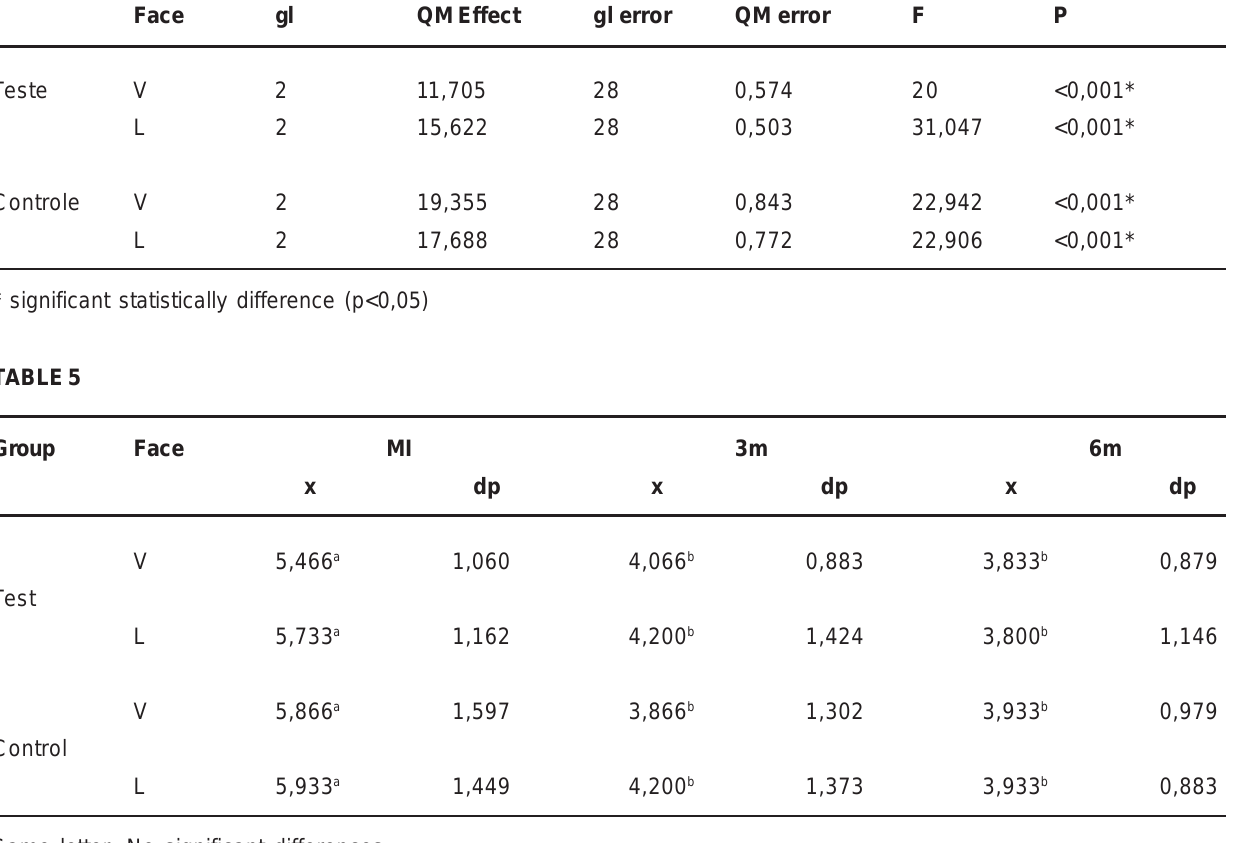
Same letter- No significant differences